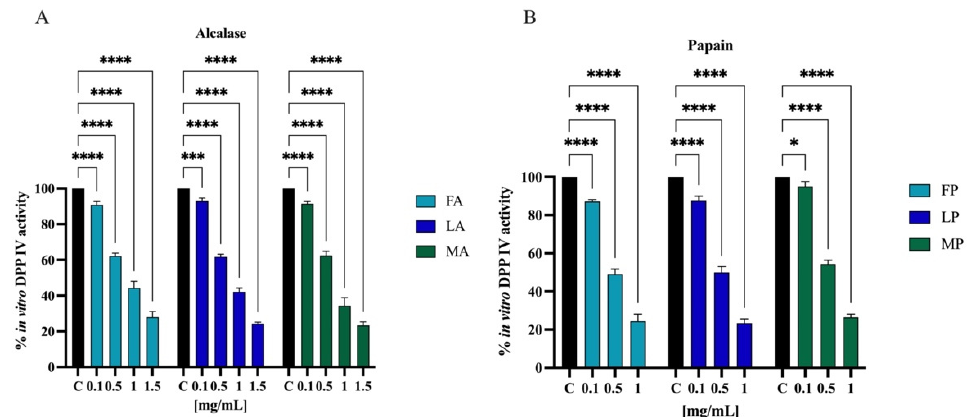
Figure 10. Effect of olive seed hydrolysates obtained from Frantoio (F), Leccino (L), and Moraiolo (M) using alcalase (A) ( A ) and papain (P) ( B ) on the in vitro DPP-IV activity, respectively. The data points represent the averages ± s.d. of four independent experiments, and each experiment was performed in triplicate. All data sets were analyzed by two-way ANOVA followed by Tukey’s post hoc test. Ns, not significant; C, control sample (H 2 O). (*) p < 0.5, (***) p < 0.001, (****) p < 0.0001.